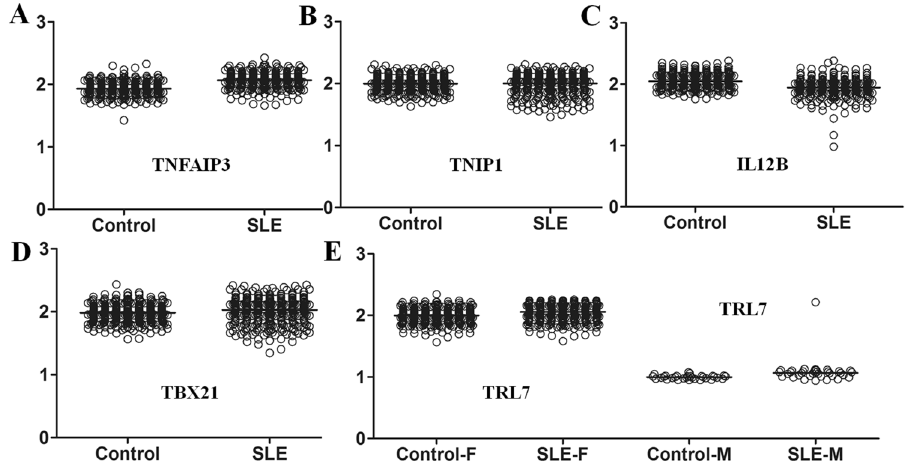
Figure 3. Difference in CNs between the controls and SLE patients in genes showing relatively low or no CNV. ( A ) TNFAIP3 ( P < 0.0001). ( B ) TNIP1 ( P = 0.7035). ( C ) IL12B ( P < 0.0001). ( D ) TBX21 ( P = 0.0043). ( E ) TLR7 ( P < 0.0001 for both male and female). Although statistical significance was observed in several genes by the Wilcoxon rank-sum test, CNVs were not evident except in IL12B and TLR7 in a few cases.